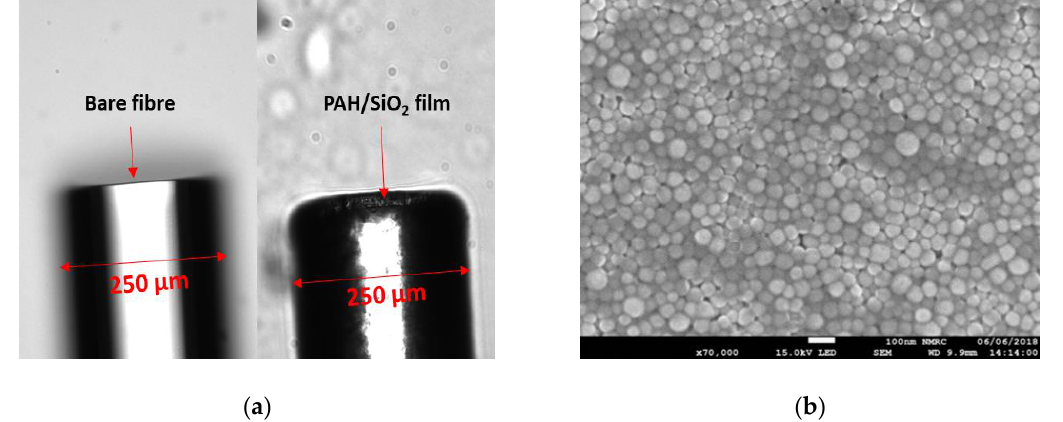
Figure 3. ( a ) Optical microscope images of cleaved fibre before (left) and after coating with 11 layers of PAH / SiO 2 NPs (right) ( b ) SEM image of PAH / SiO 2 NPs film deposited onto a fibre tip. The value of the scale bar is 100 nm.